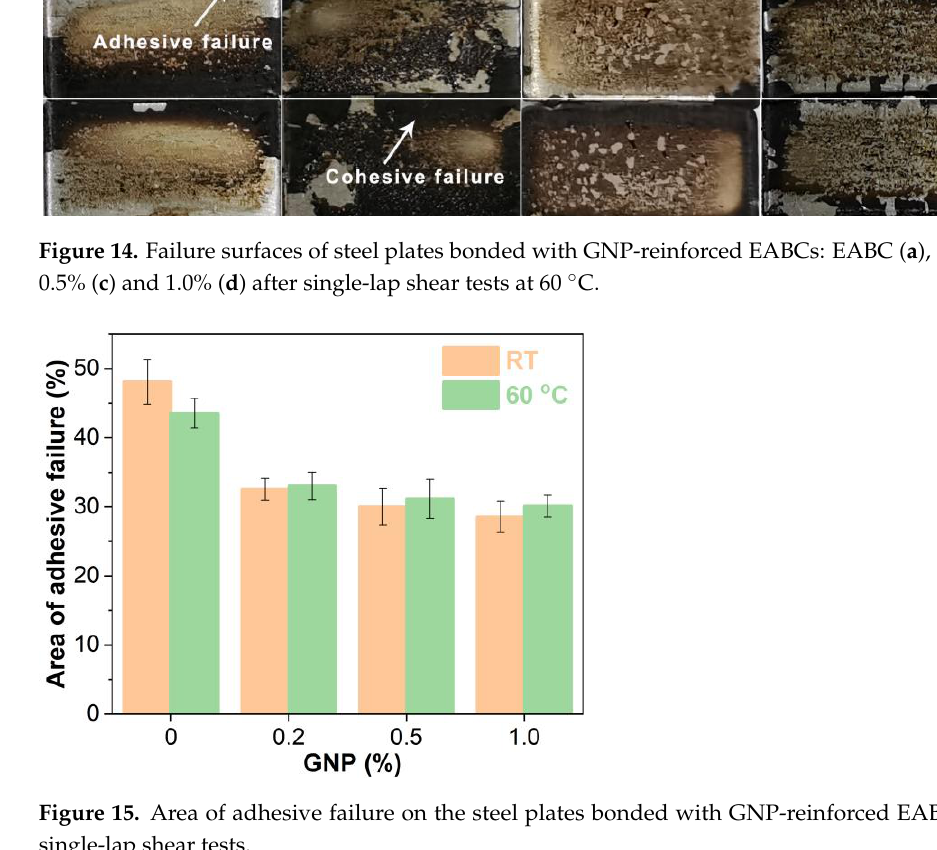
Figure 13. Failure surfaces of steel plates bonded with GNP-reinforced EABCs: EABC ( a ), 0.2% ( b ), 0.5% ( c ) and 1.0% ( d ) after single-lap shear tests at room temperature. Figure 14. Failure surfaces of steel plates bonded with GNP-reinforced EABCs: EABC ( a ), 0.2% ( b ), 0.5% ( c ) and 1.0% ( d ) after single-lap shear tests at 60 °C.